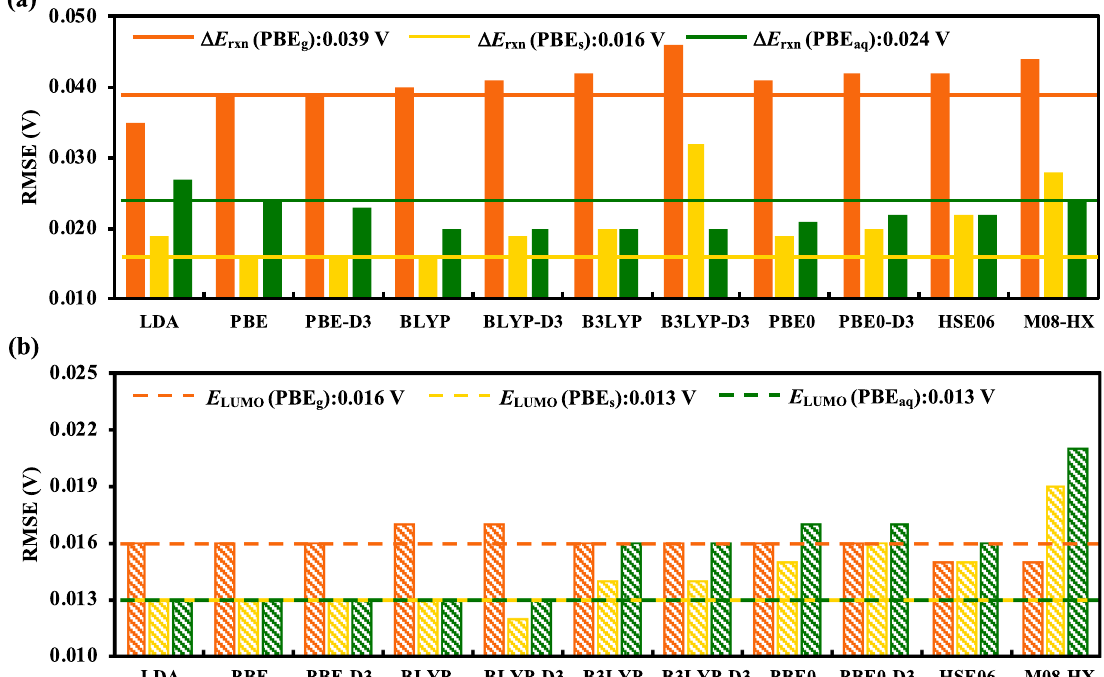
Figure 3. Performance comparison of various exchange–correlation functionals for predicting E o exp . The bar plots ( a ) and ( b ) show the RMSEs for descriptors (cid:31) E rxn and E LUMO , respectively. The color orange represents both OPT and SPE in gas-phase, the color yellow represents OPT in gas-phase followed by SPE with SOL, and the color green represents both OPT and SPE with